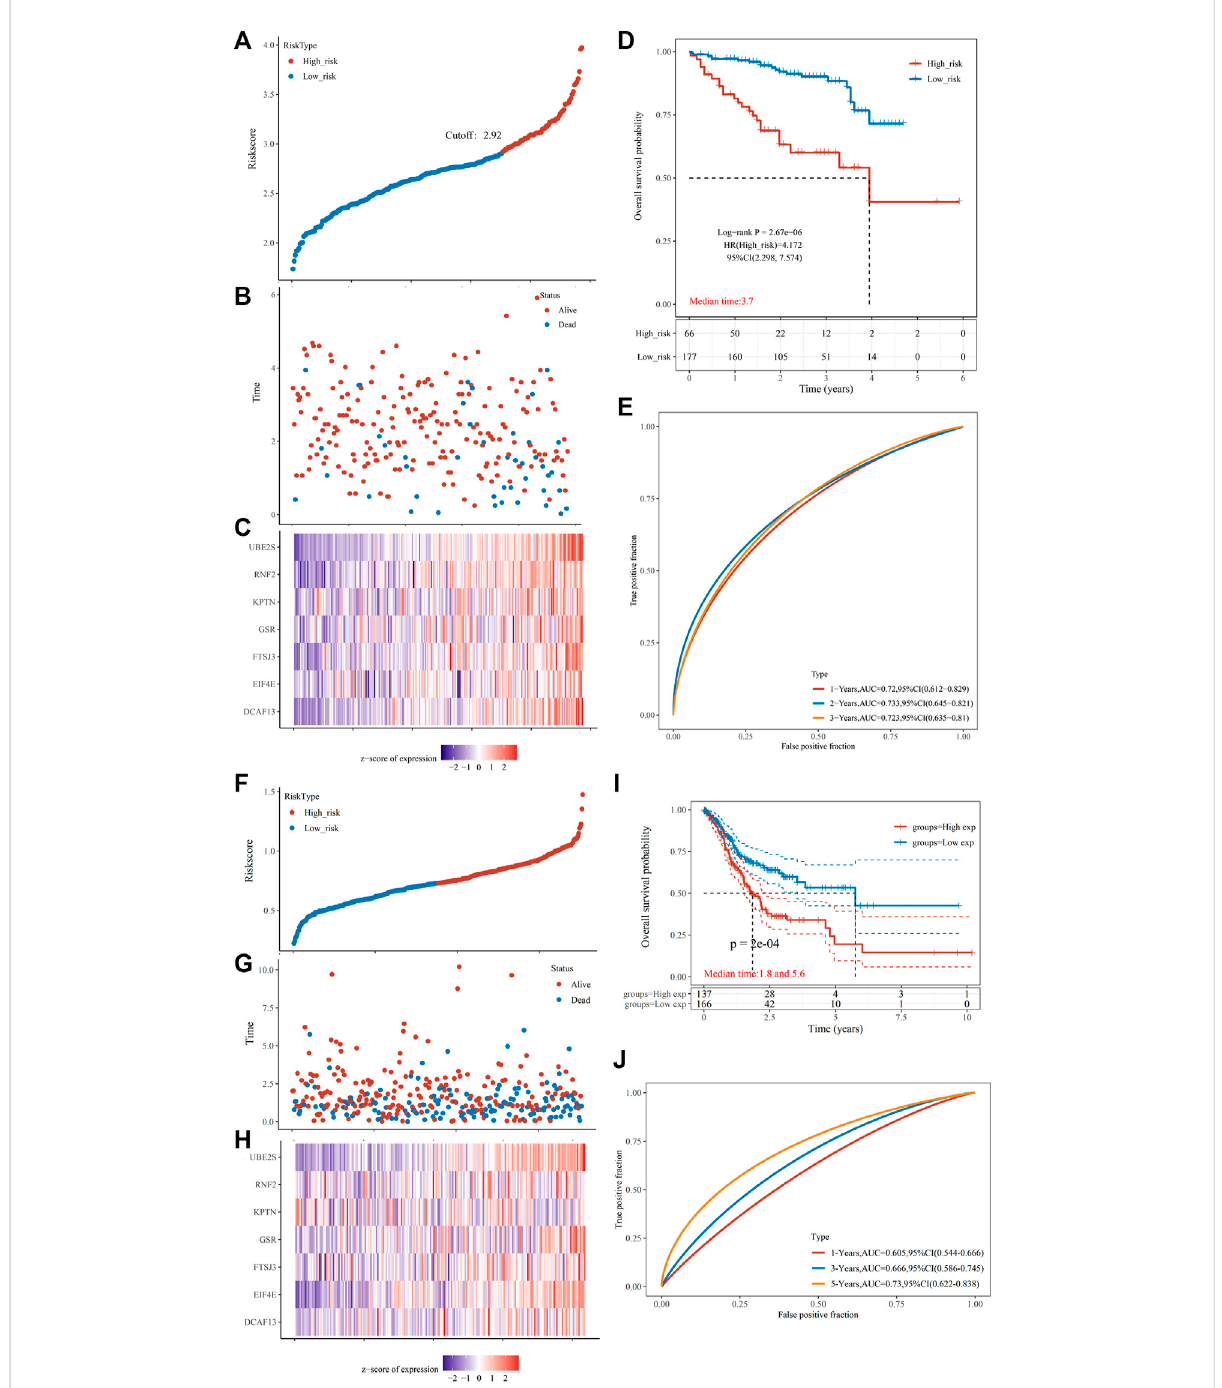
FIGURE 8 Prognosticriskscorefeaturesofpyroptosis-regulatedgenesinthevalidationgroups (A) Thescatterplotdisplayingtheriskscorefromlowtohighinthe validationgroup1(ICGC). Thebluecolor indicateslow risk group.Theyellowcolorindicateshighrisk group. (B) Thescatterplotshowingthedistributionof theriskscoresofeachsamplecorrespondingtothesurvivaltimeandsurvivalstatusinthevalidationgroup1. (C) Theheatmapillustratingthegeneexpression patternofthepyroptosis-regulatedsignature. (D) Kaplan-MeierPlotteroftheriskmodelvalidationgroup1.Differentgroupswerecomparedusingthe log-ranktest. (E) TheROCcurveat1,2and3yearsandAUCofthepyroptosis-regulatedsignature. (F) Thescatterplotshowingtheriskscoresfromlowtohigh in the validation group 2 (HCCDB6and HCCDB17). The blue color indicates low risk group. The yellow color indicates high risk group. (G) The scatter plot demonstratingthedistributionpatternoftheriskscoresofeachsamplecorrespondingtothesurvivaltimeandsurvivalstatusinthevalidationgroup2. (H) The heatmap showing the gene expression of the pyroptosis-regulated signature. (I) Kaplan-Meier Plotter of the risk model validation group 2. Different groups were compared using the log-rank test. (J) The ROC curve at 1, 2 and 3 years and AUC of the pyroptosis-regulated